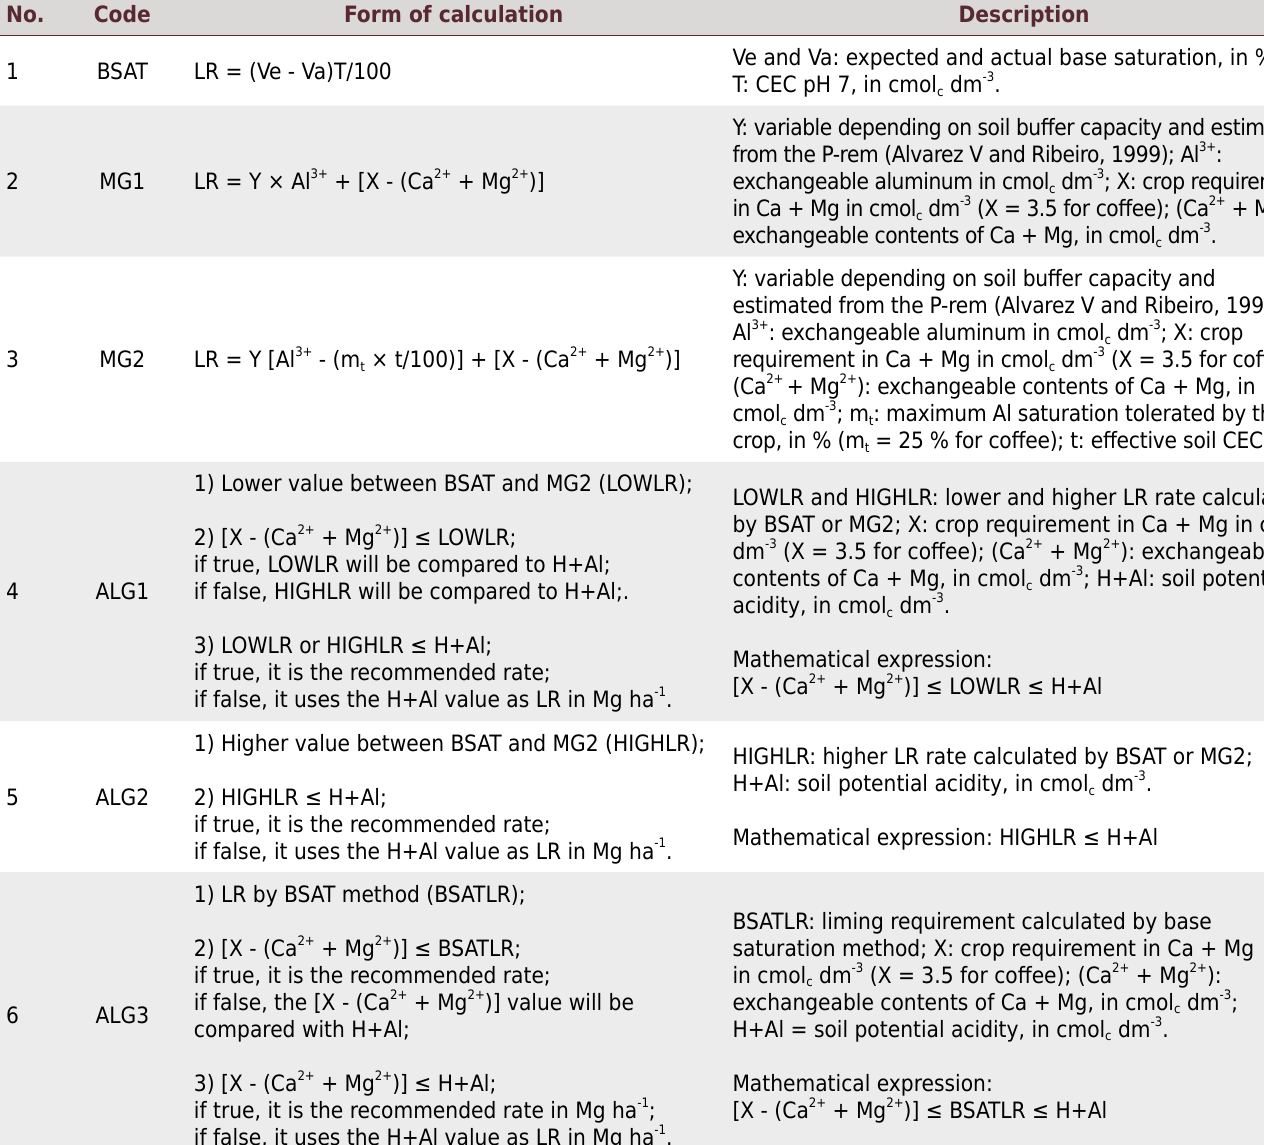
Table 1. Calculation methods for determination of liming requirement (LR) No. Code Form of